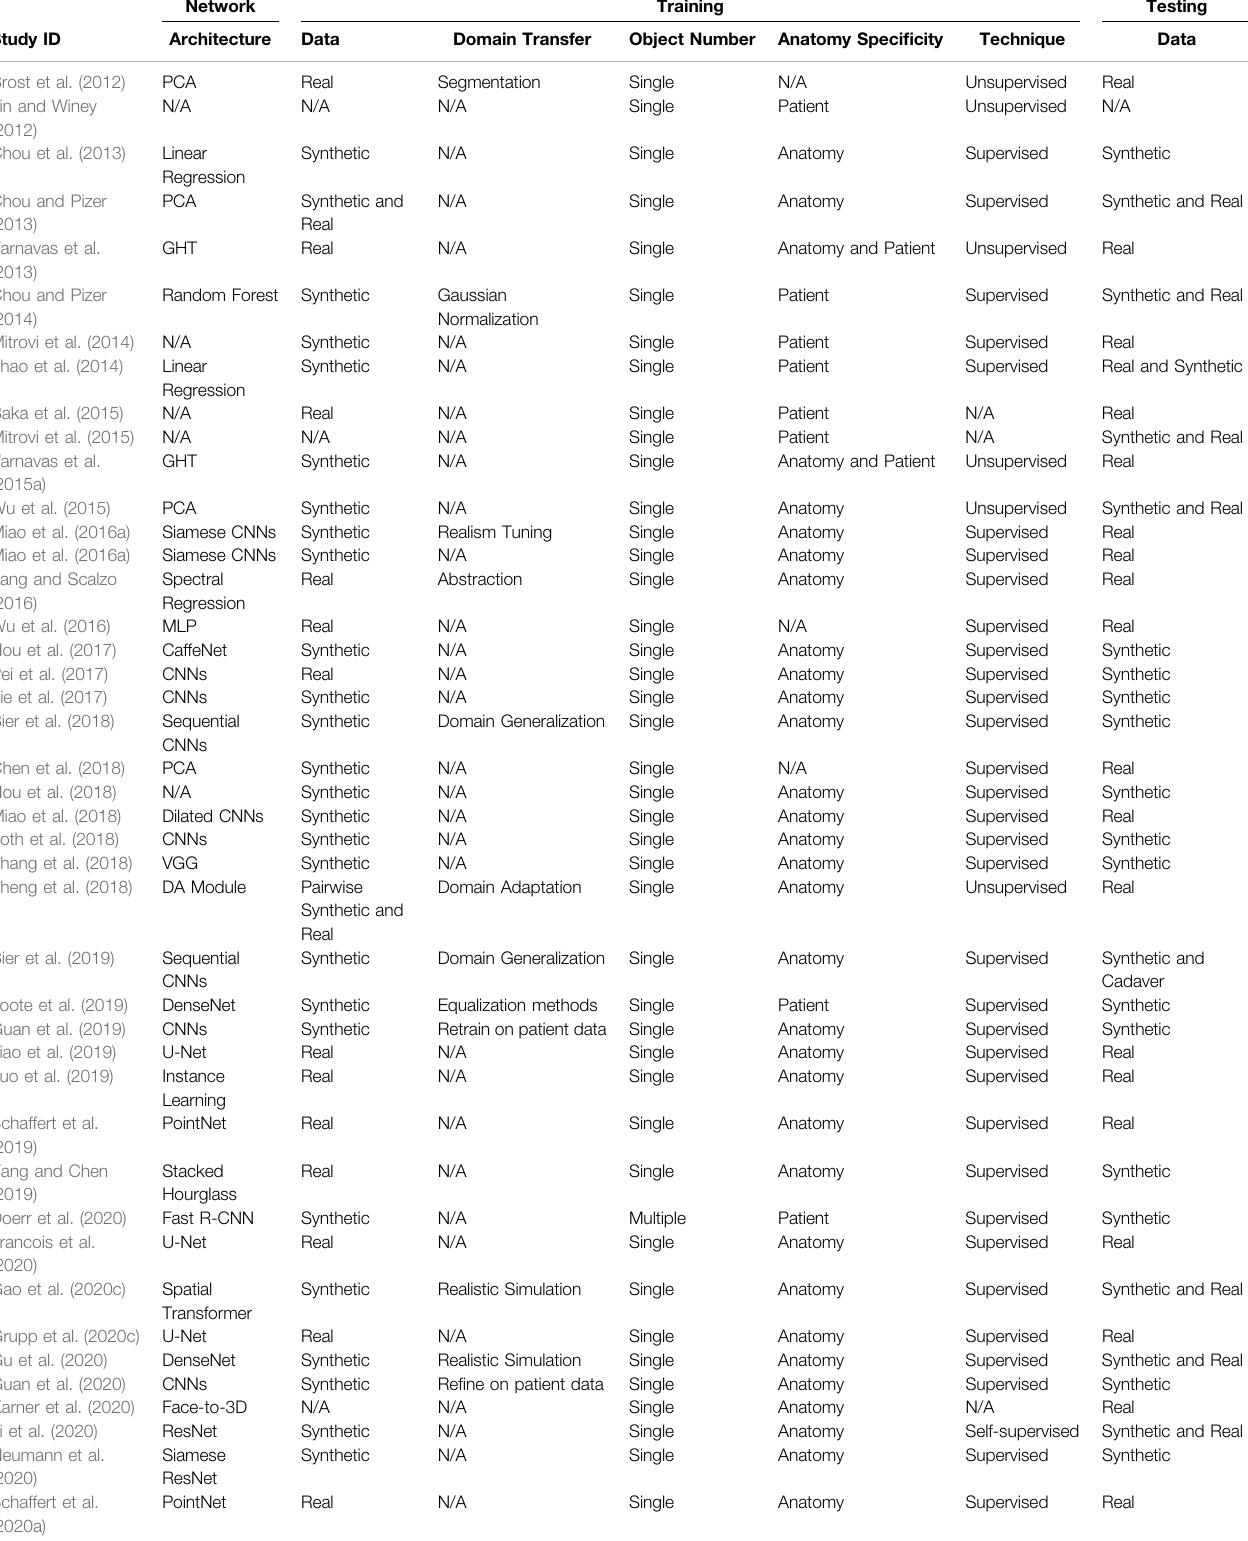
TABLE 2 | A summary of the training and testing details for each study